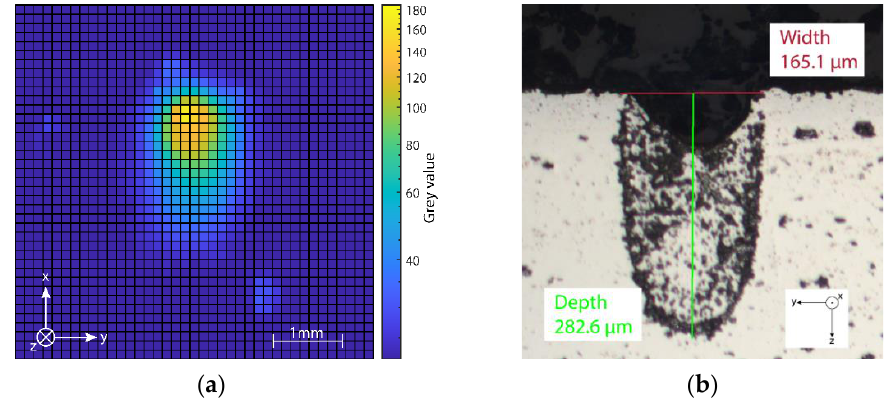
Figure 9. Comparison between: ( a ) A thermal image of an exposure with a laser power of 460 W and a scan speed of 1 m/s and ( b ) the metallurgical microscopy of the aluminum plate. The melt pool has a measured width of 165.1 μm and a measured depth of 282.6 μm.